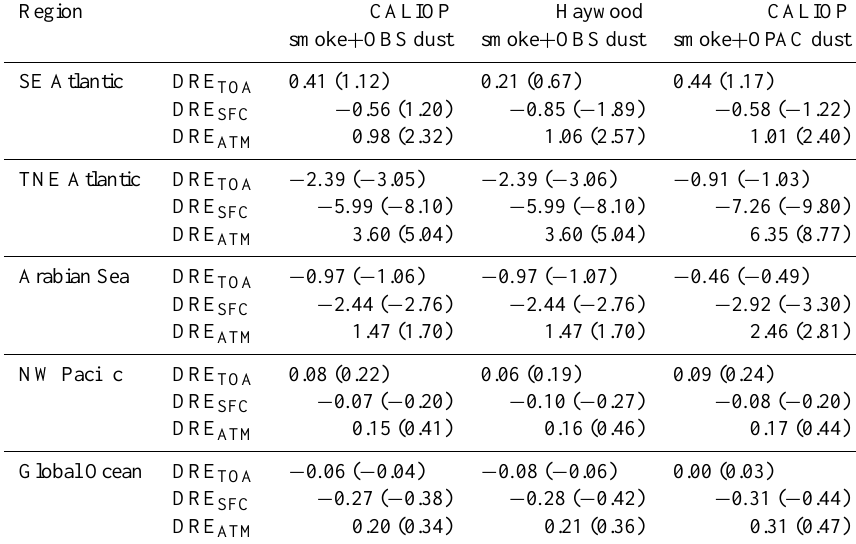
Table 5. Same as Table 4, except for JJA seasonal